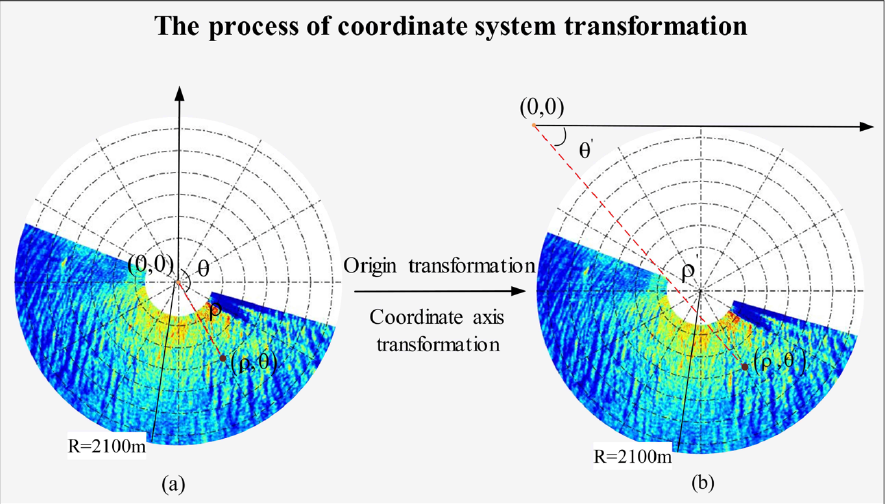
Figure 3. Process of co-ordinate system transformation on 00:20 UTC+8 27 October 2010. ( a ) Polar co-ordinate system; ( b ) image polar co-ordinate system.